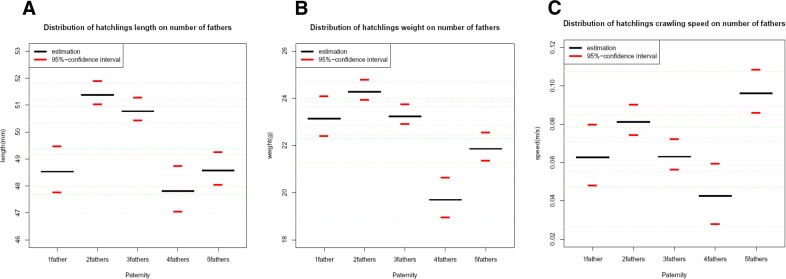
Distributions of correlated morphological traits with 95% confidence intervals.Distributions of length (A), weight (B) and speed (C) of green turtle hatchlings under categories specifying the exact number of inferred fathers on each nest (e.g., SP = 1 father; MP = 2 fathers, 3 fathers, 4 fathers and 5 fathers). The red lines indicate the 95% confidence interval. The diagrams revealed the tendency of higher values within the groups of two and three fathers for the length and weight traits. However, an exception to pattern was measured for the crawling speed (C) trait, which showed its highest values for the five fathers group. These results suggest a significant difference in fitness (as measured by our criteria) between hatchlings resulting from clutches fathered by one or more fathers.